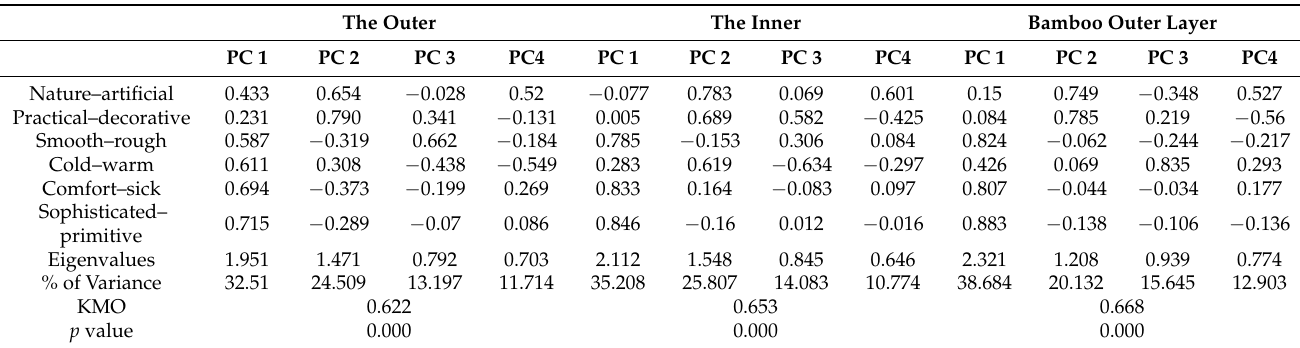
Table 7. Principal component analysis of psychological quantities.